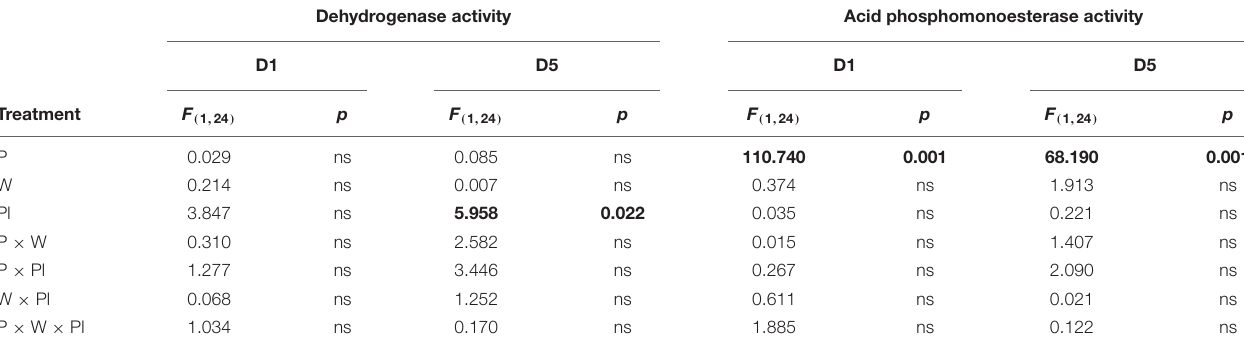
TABLE 4 | Test statistics and p value summary table for dehydrogenase and acid